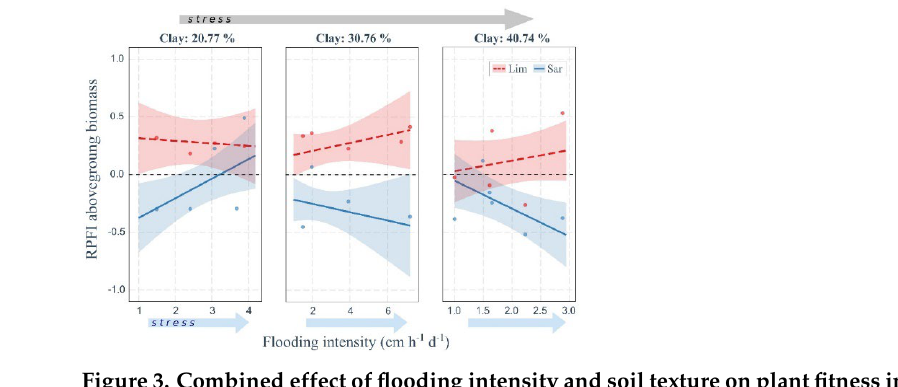
Figure 3. Combined effect of flooding intensity and soil texture on plant fitness in terms of aboveground biomass. Positive values of RPFI denote larger fitness of the species when growing in plurispecific stands compared to monospecific plant communities. Arrows indicate the increasing stress gradient of flooding (light blue arrow) or of harsher soil conditions (grey arrow, i.e., increasing soil clay content). Only significant relationships obtained from the ANOVA applied on linear models are shown (see Table S2, R 2 = 0.56). Lim or Sar labels indicate the target species Limonium narbonense or Sarcocornia fruticosa , respectively. Significant differences in slopes at different levels of clay content in soil were found for S. fruticosa only (see Table S2).